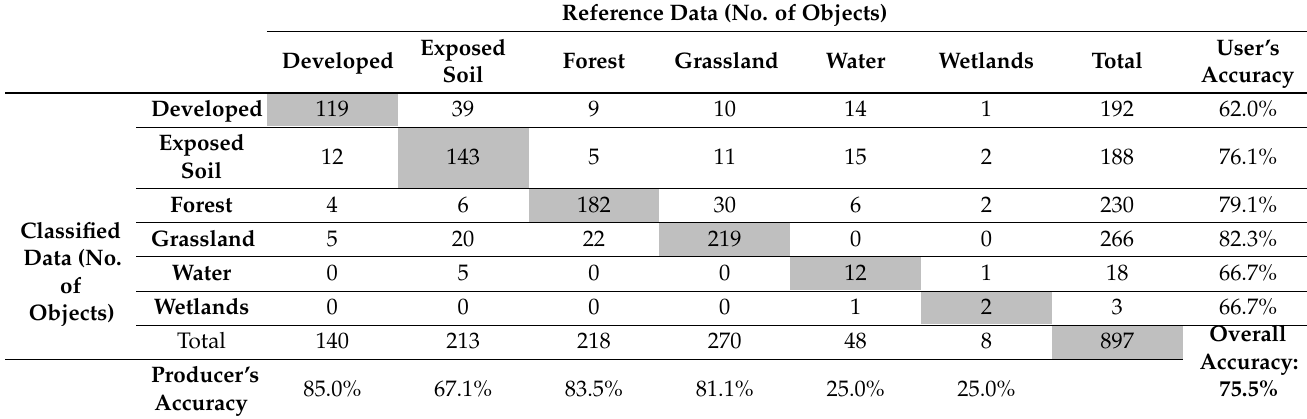
Table 6. Confusion matrix for an SVM-RFE classification of the North Carolina dataset trained from the small sample set ( n =